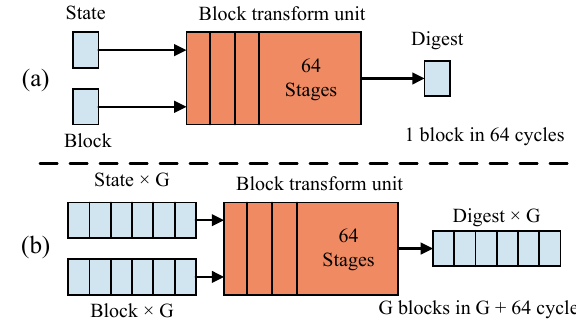
Figure 9: (a) Pipeline without group scheduling. (b) Pipeline with group